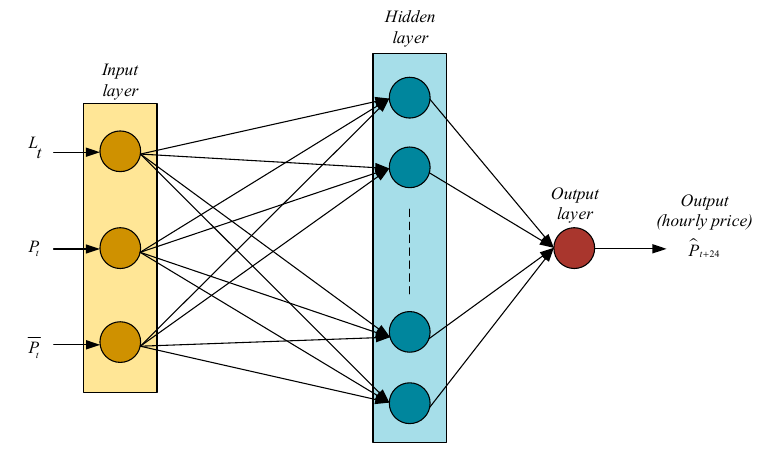
Figure 5. Neural network architecture diagram.